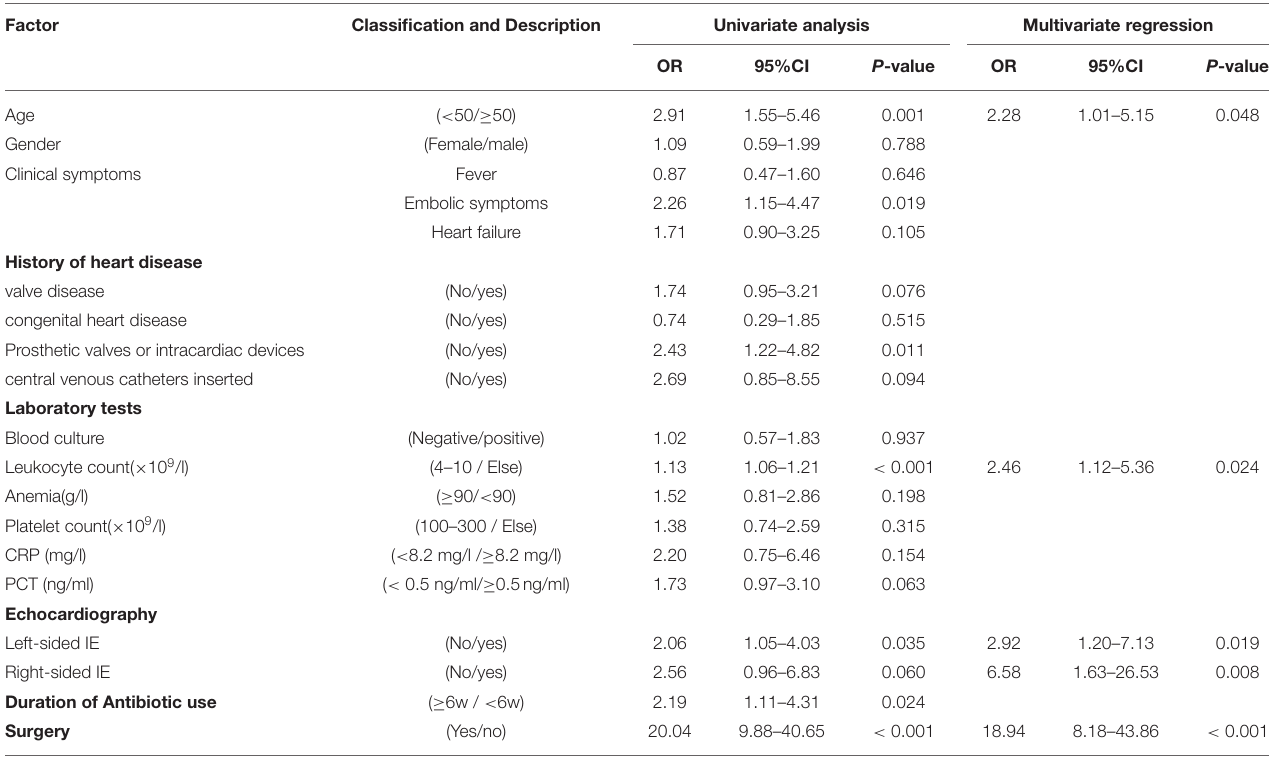
TABLE 3 | Univariate and multivariate logistic regression analysis of in-hospital mortality in infective endocarditis.